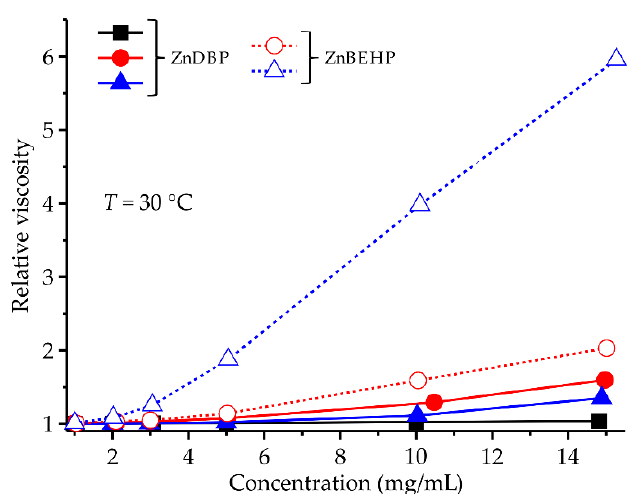
Figure 4. Variation of relative viscosity with concentration of ZnDBP or ZnBEHP solutions in selected organic solvents: methanol (black line), chloroform (red line) and toluene (blue line). The measurements were carried out at 30 °C.